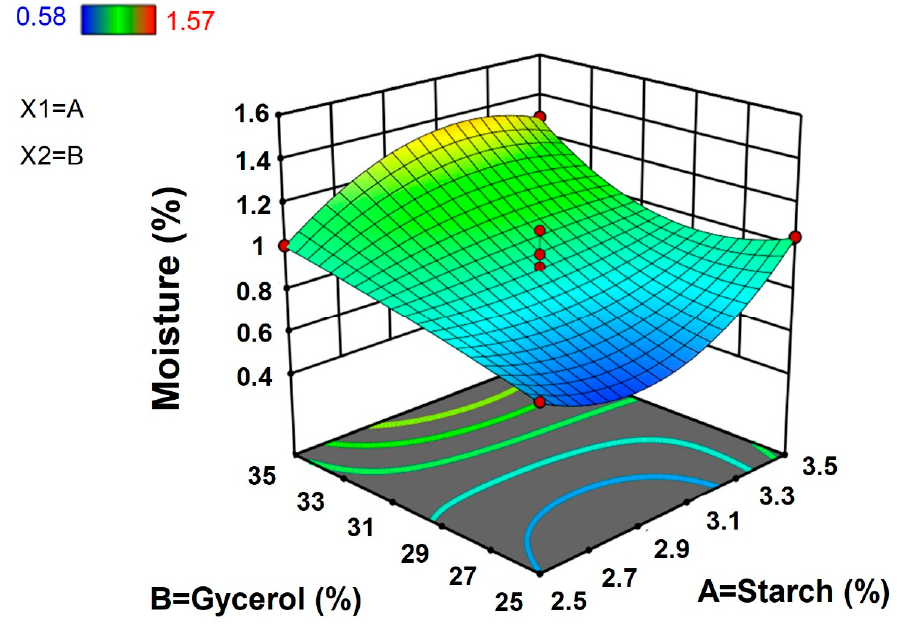
Figure 3. Response surface plot for moisture content of taro peel starch biodegradable films. Table 3. Equation for responses.